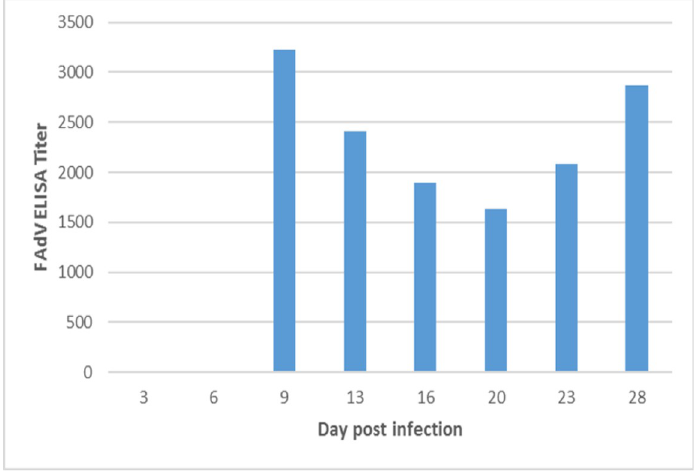
Fig 7. Antibody response to viral proteins in chickens inoculated with FAdV isolate MOR300315 by an oral route as measured by ELISA. Five sera samples from inoculated chickens were randomly collected at 3, 6, 9, 13, 16, 20, 23 and 28dpi. The bar representing the titer at 3 and 6 dpi are not visible as antibodies were not detected.